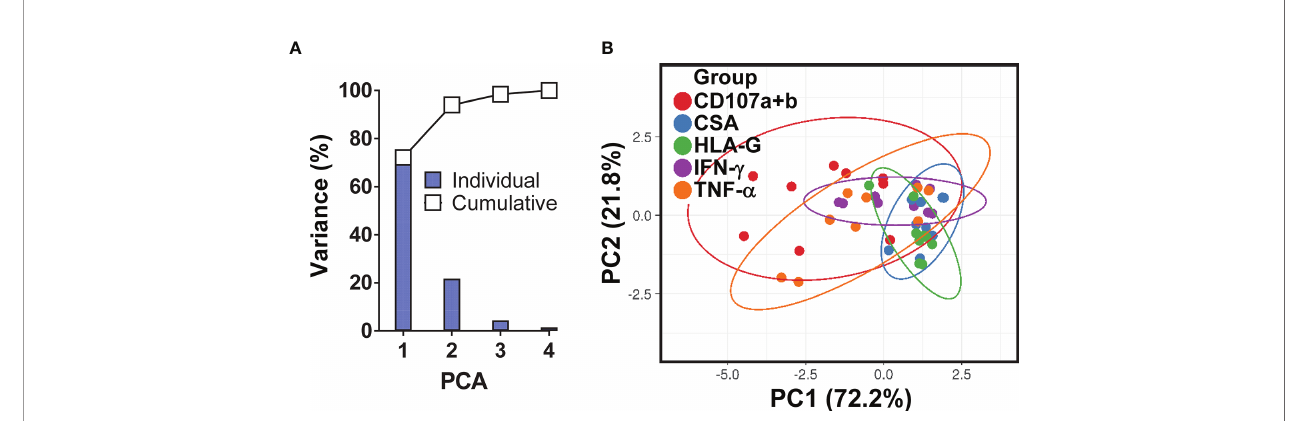
FIGURE 4 | Principal Component (PC) Analysis variances. (A) The percent variations are plotted for each component (bars) and cumulatively (line). (B) Ability of PCA to cluster the levels of HLA-G and S . Typhi antigen (CSA) expression on B-LCLs and production of IFN- g and TNF- a cytokines and expression of CD107a & b by MAIT cells. Unit variance scaling is applied to rows; singular value decomposition (SVD) with imputation is used to calculate principal components. X and Y axis show PC1 and PC2 that explain 72.2% and 21.8% of the total variance, respectively. Prediction ellipses are such that with probability 0.95, a new observation from the same group will fall inside the ellipse. Each dot represents a single experimental condition and volunteer, where each PC summarizes the variance of 75 data points for 3 experimental conditions (MAIT cells exposed to uninfected, or S . Typhi-infected B-LCLs that were treated with a neutralizing mAb to HLA-G (HLA-G), or isotype control (ISO) in 5 individual